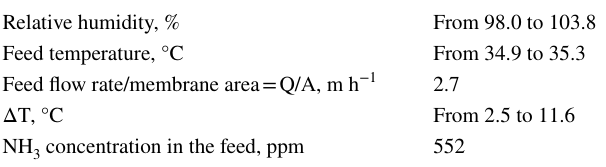
Table 1 Operative conditions utilized in the experimental tests Relative humidity, % From 98.0 to 103.8